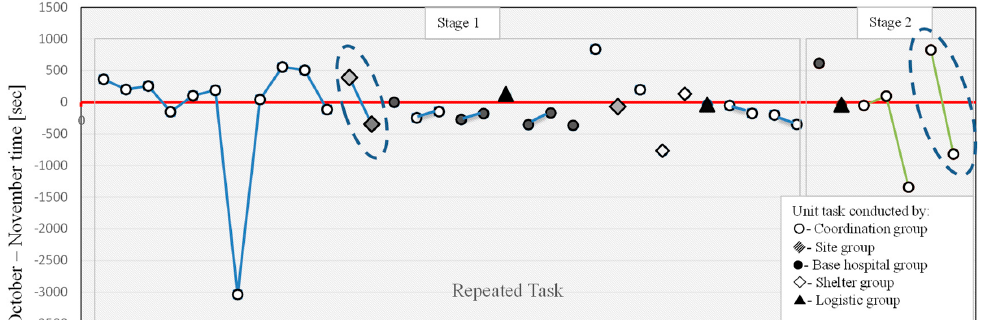
ff erences in task processing time for 39 repeated unit Figure 5. Differences in task processing time for 39 repeated unit tasks. Figure 5. Di